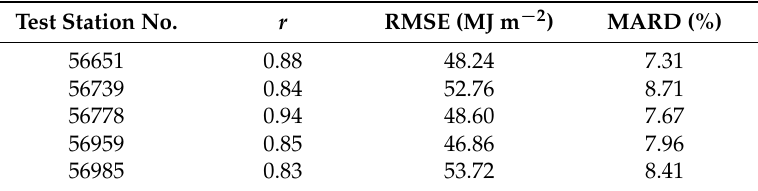
Table 2. Statistics for the cross-validation of the improved YHM model.